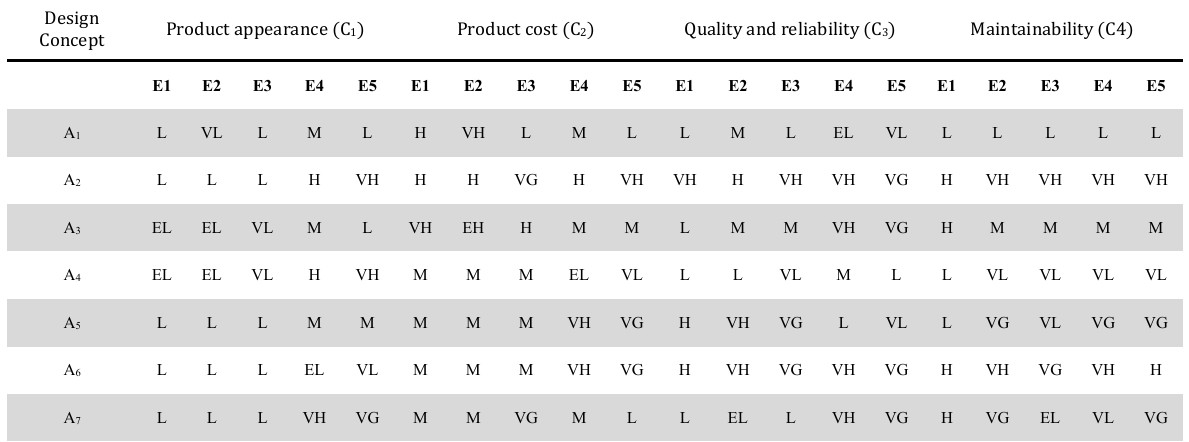
The Linguistic evaluations ofseven Design concepts by the five